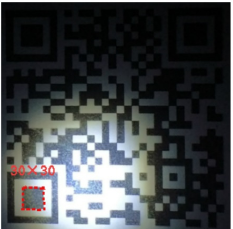
Figure 6. The size of middle module.